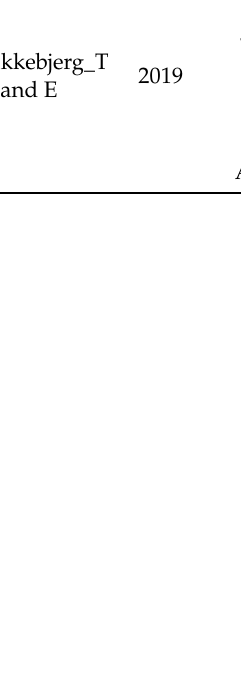
Table 4. Soil characteristics of the locations used for calibration and evaluation of APSIM.